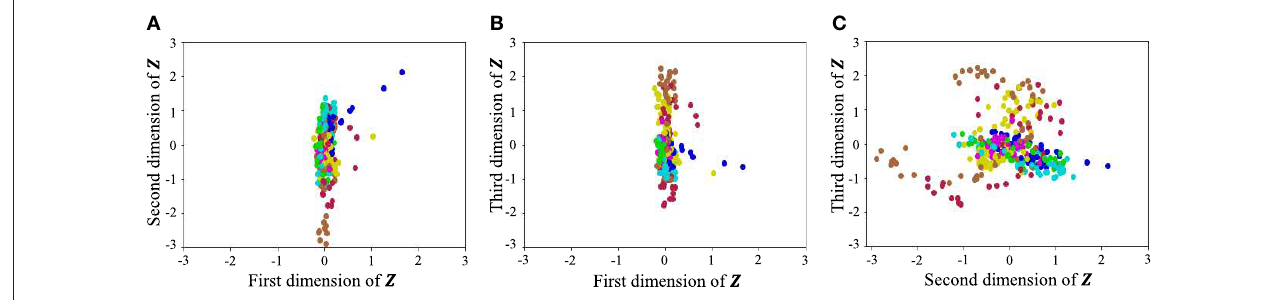
FIGURE 18 | Latent space of the VAE: (A–C) respectively represent the first and second, first and third, and second and third dimension of the latent variables. The color of each point, which is latent variable reflects the correct motion class.